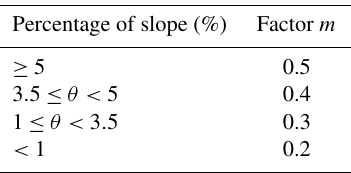
Table 1. Variation of m as a function of the slope (Payet et al.,